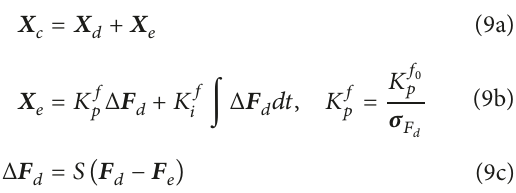
Figure 5: Schemeof hybrid force/position control for force-relevant tasks. 𝐹 𝑑 refers to the desired contact force.